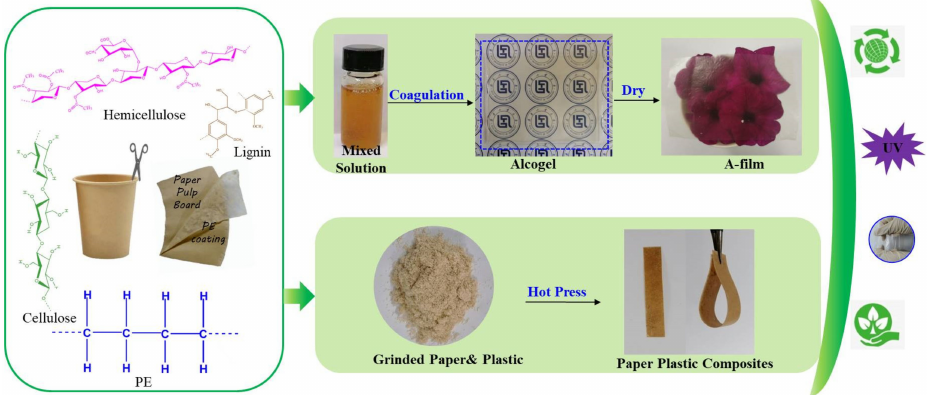
Figure 2. Process of converting waste disposable paper cups (WDPC) into cellulose-based films (H-film and A-film) and paper plastic composites (PPC) by AmimCl and hot press